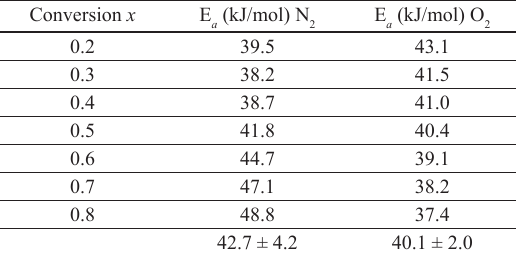
Table 3. Activation energy (E for unirradiated green LLDPE. TGA experiments carried out at 10, 30 and 50 °C.min -1 heating rates under N using Starink method 27 .